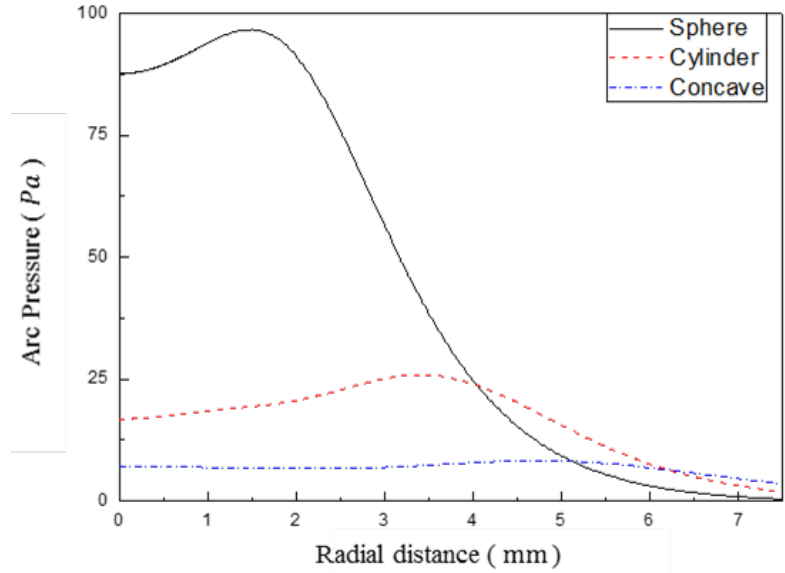
Figure 11. Arc pressure on the anode according to obstruction structure shape.